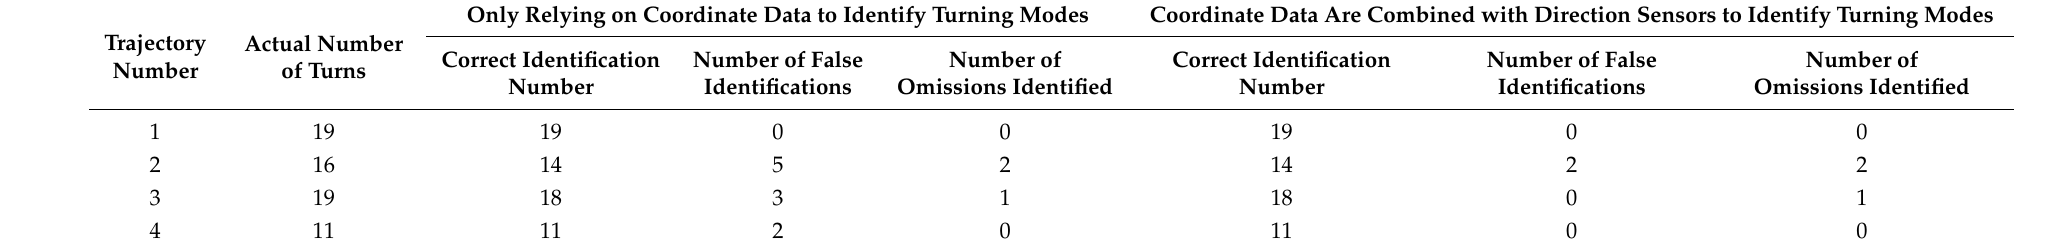
Table 2. Recognition accuracy of turning modes when the compression threshold is set to 3 m.